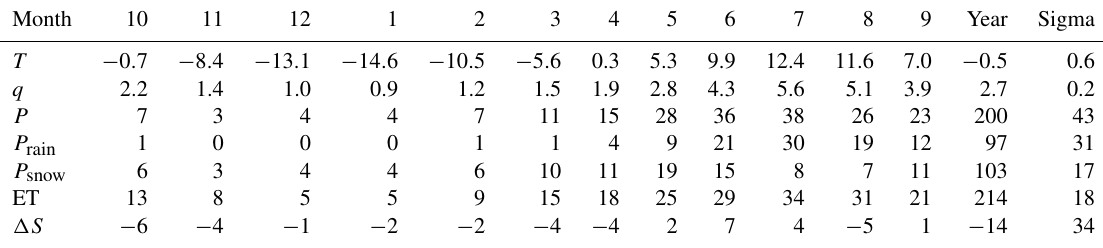
Table 1. Mean monthly and annual air temperature T (in ◦ C), specific humidity q (in gkg − 1 ), precipitation P (in millimetres per month or millimetres per year), rainfall P rain (in millimetres per month or millimetres per year), snowfall P snow (in millimetres per month or millimetres per year), actual evapotranspiration ET (in millimetres per month or millimetres per year), and water balance (cid:49)S = P − ET (in millimetres per month or millimetres per year) in the Qaidam Basin (QB) derived from the HAR 10km data set; Sigma: standard deviations of annual values for each quantity during the hydrological years 2001 to